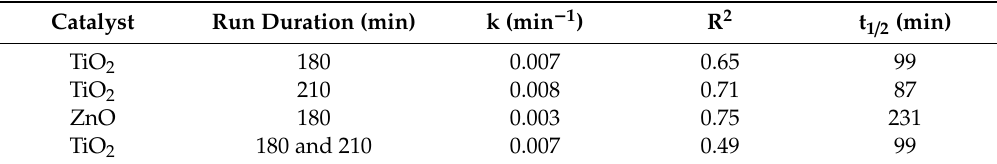
Table 3. Kinetic parameters for COD degradation by TiO 2 and ZnO (process conditions: pH—4, UV